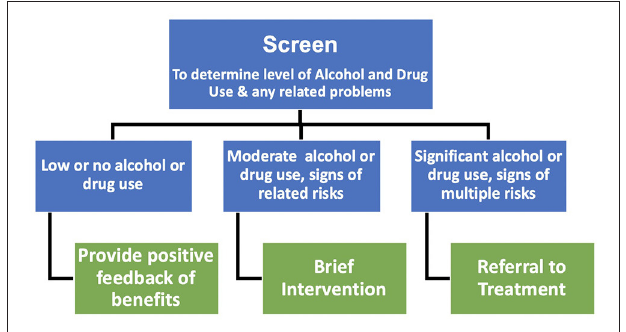
FIGURE 1 | Screening, Brief Intervention and Referral to Treatment